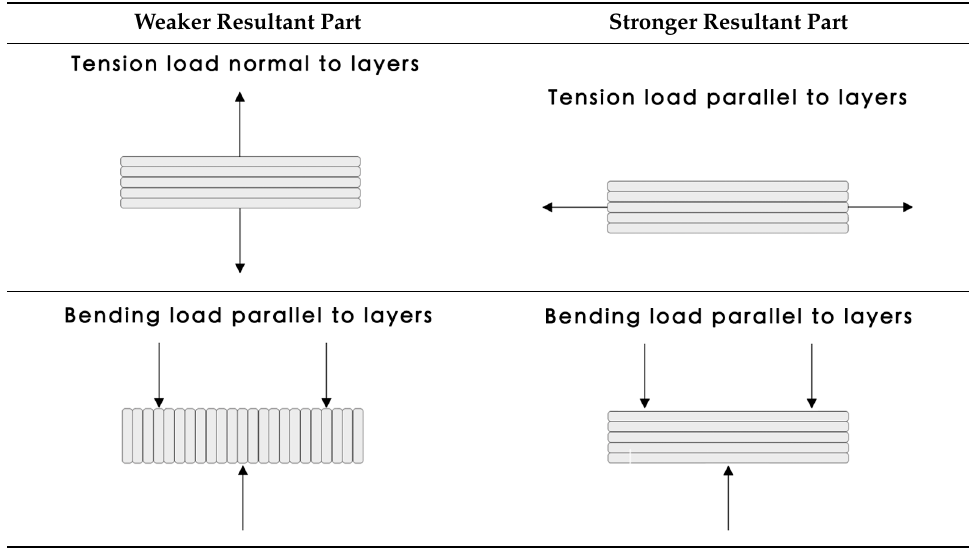
Table 4. Build direction and its e ff ects on part weakness [2]. Table 4. Build direction and its effects on part weakness [2]. Table 4. Build direction and its effects on part weakness [2]. Table 4. Build direction and its effects on part weakness [2]. Table 4. Build direction and its effects on part weakness [2].